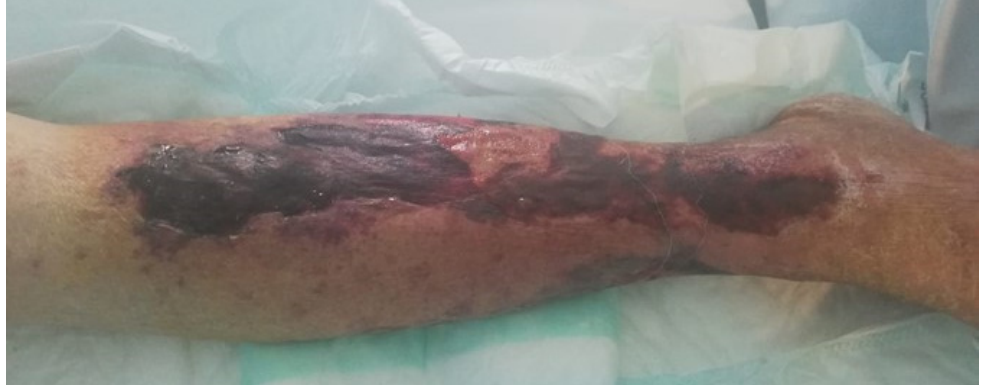
Figure 2. Necrotic purpuric plaques with ulcerations.